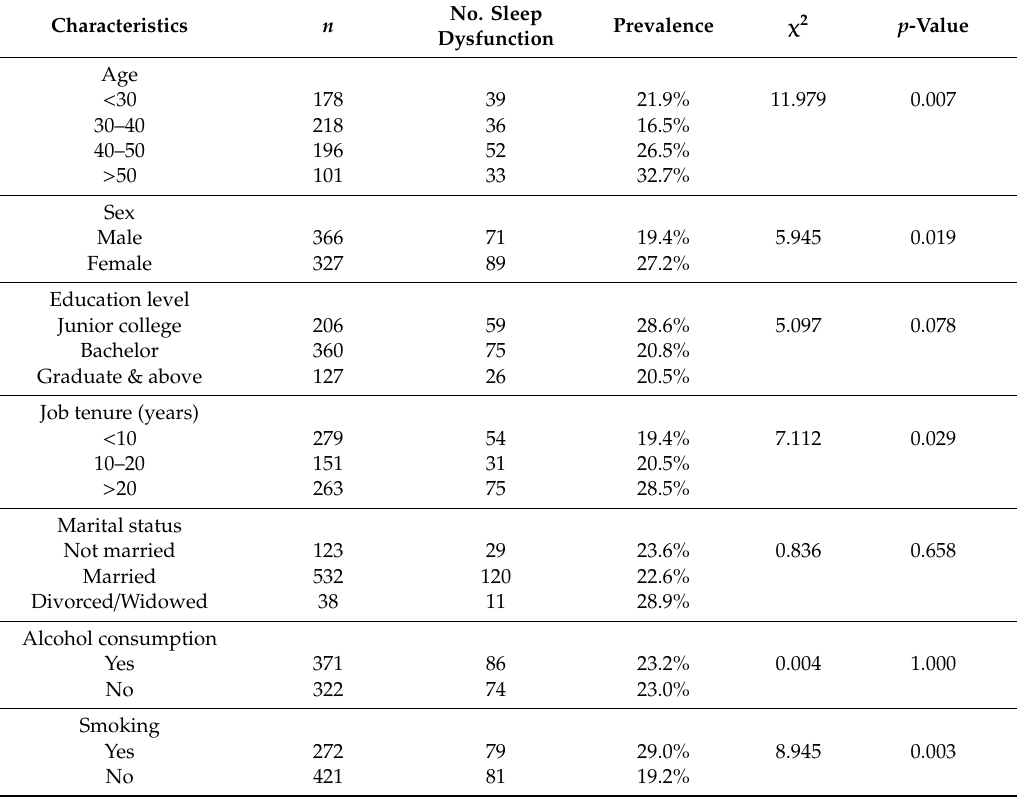
Table 2. Prevalence of sleep dysfunction by subject characteristics.